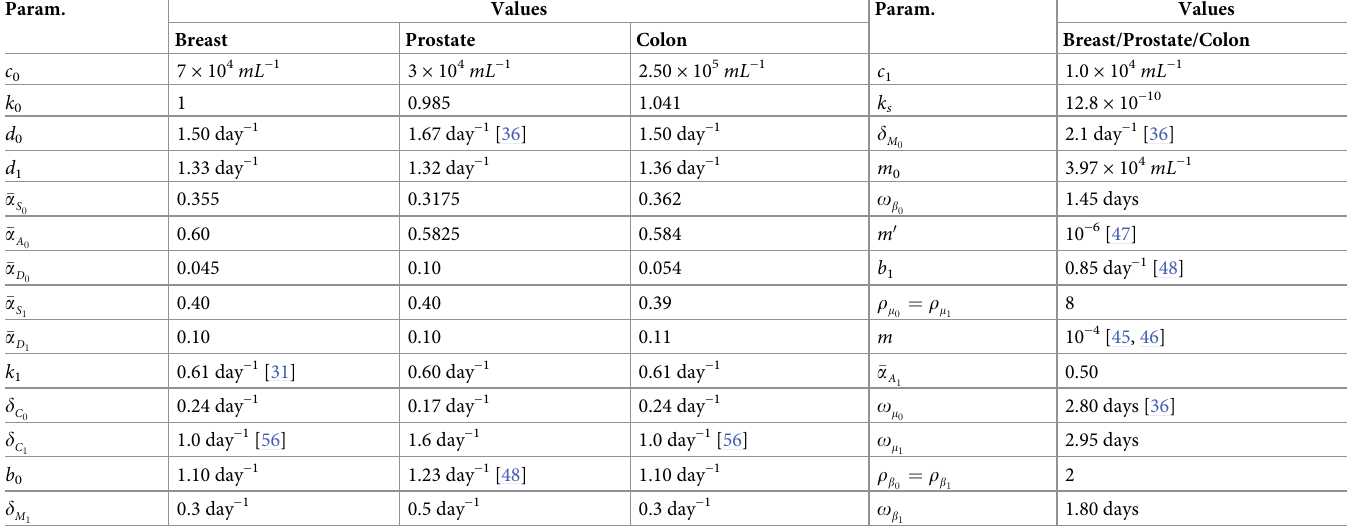
Table 2. Parameters used for model validation in Fig 9. The values of the parameters used in the simulations of Fig 9 are presented for all three cancer types.